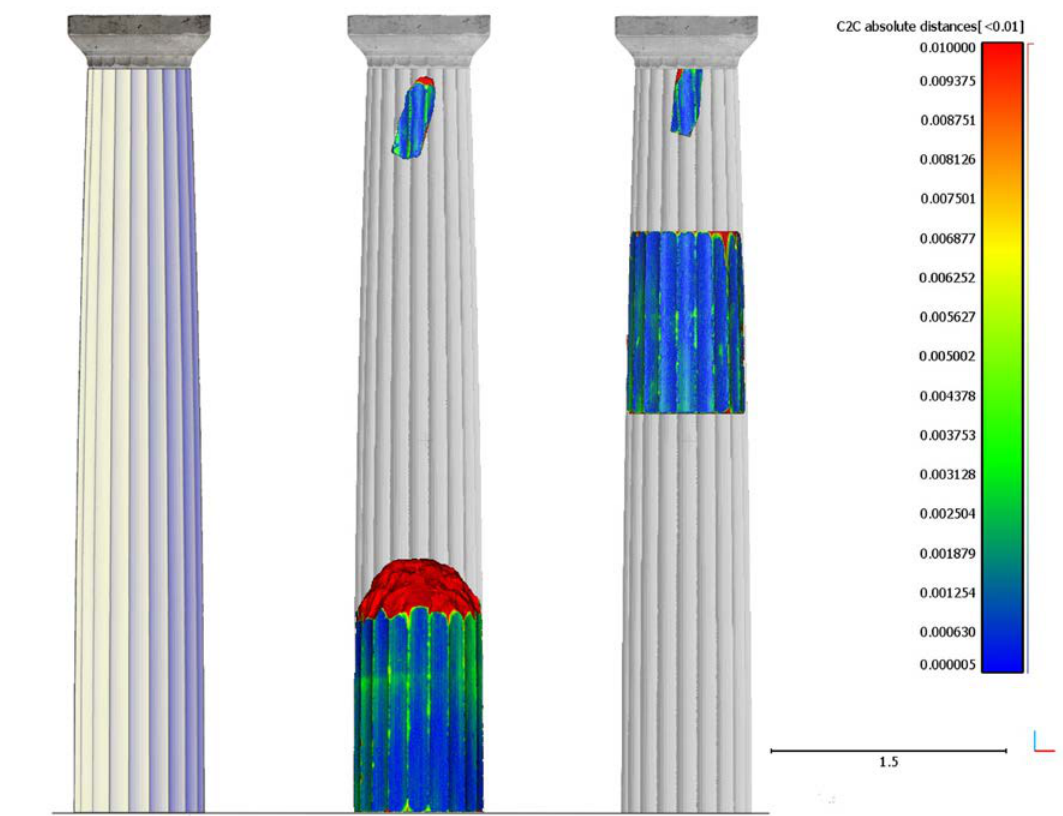
Figure 6.Left: The 3D model of the “ideal” column shaft, with the Doric capital placed on top of it. Middle: In Cloud Compare ® software Fine Registration (ICP) of ideal model with the lower column drum and one of the fragments. The colour scale represents distances between the point clouds. Note that the broken arises are shown with green colour. Right: Fine Registration (ICP) of a fragment and the column drum from north of the Acropolis with the ideal model, which shows their original position on the column